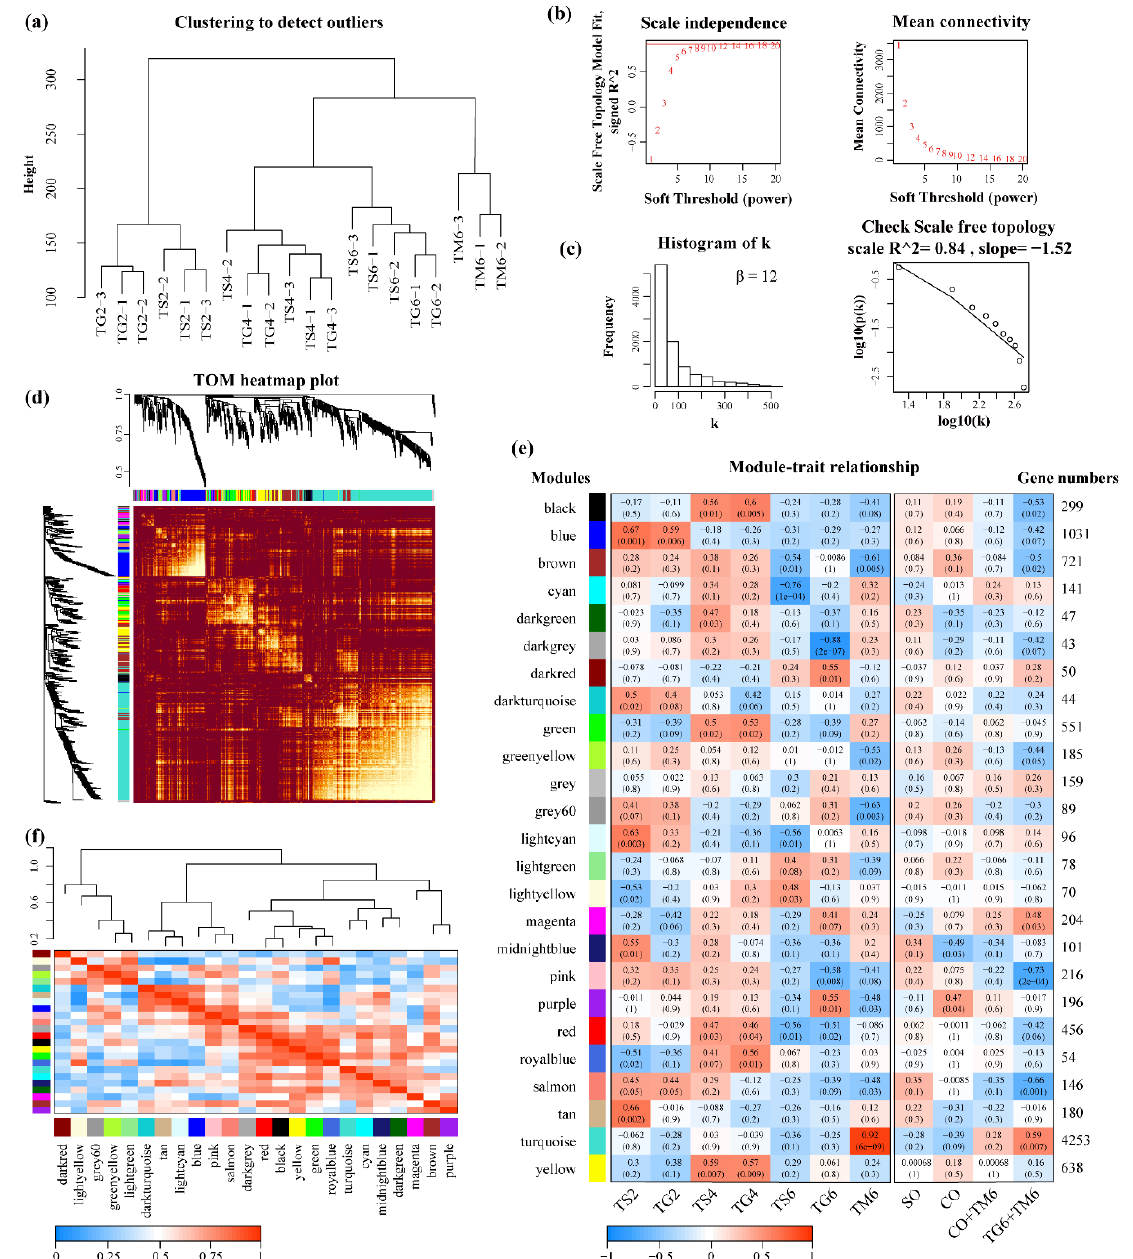
Figure 5. Co-expression network analysis across different compared groups. ( a ) Clustering dendrogram of 20 samples for detecting outliers. ( b ) Analyses of network topology for various soft-thresholding powers ( β ); the scale-free topology was set as 0.85, which is marked with the red line in the scale independence plot. ( c ) Histogram of connectivity distribution and checking the scale-free topology (R 2 = 0.84) when β = 12. ( d ) Clustering dendrogram of all expressed genes and visualizing the gene network using a heatmap plot. The longitudinal distance represents the distance between the two genes, and the lateral distance is arbitrary. Different colors represent different modules. The heatmap represents the topological overlap matrix (TOM) among all genes. ( e ) Module–trait relationship. Each row represents a module eigengene, and each column represents a trait (comparing group). The correlation and p -value are shown in corresponding cells. The table is colored based on correlation: low to high represents blue through white to red. SO represents the trait for three solitary groups (TS2, TS4, and TS6), while CO represents the trait for three conspecific groups (TG2, TG4, and TG6). ( f ) Cluster analysis of eigengenes and heatmap of connectivity of